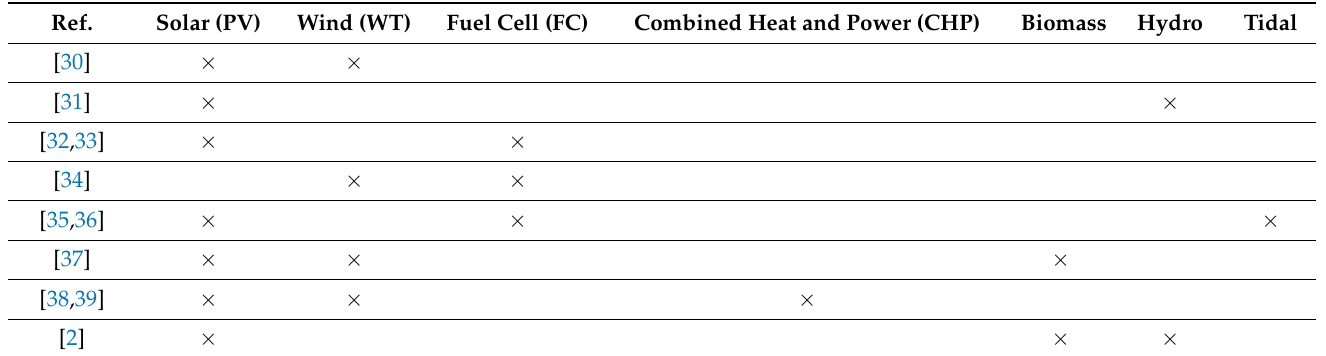
Table 4. Sustainable energy systems in